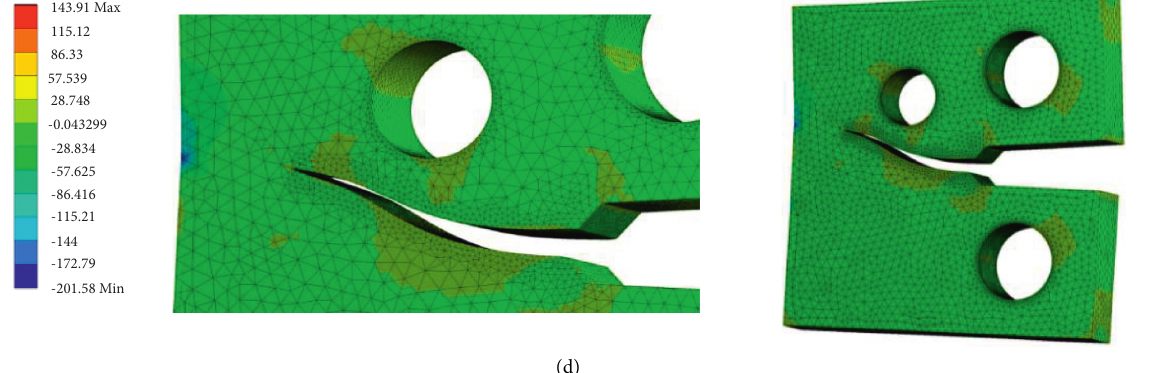
Figure 11: For CT03 specimen, (a) FRANC2D/L, maximum principal stress, (b) ANSYS, maximum principal stress, (c) FRANC2D/L, minimum principal stress, and (d) ANSYS, minimum principal